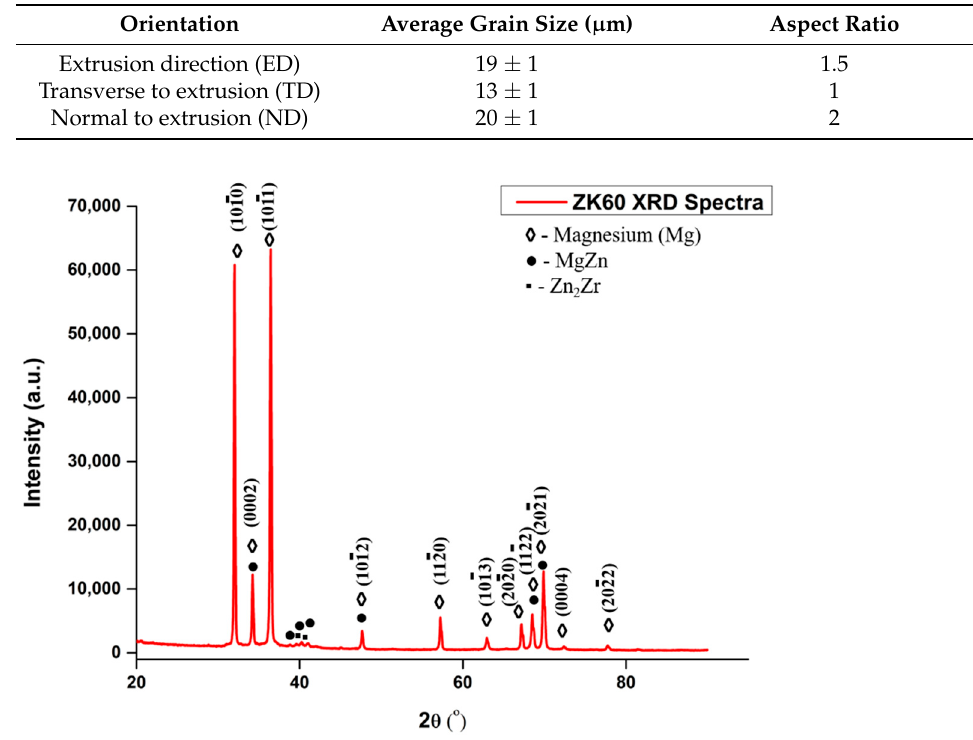
Figure 3. XRD spectrum of the extruded ZK60 alloy.